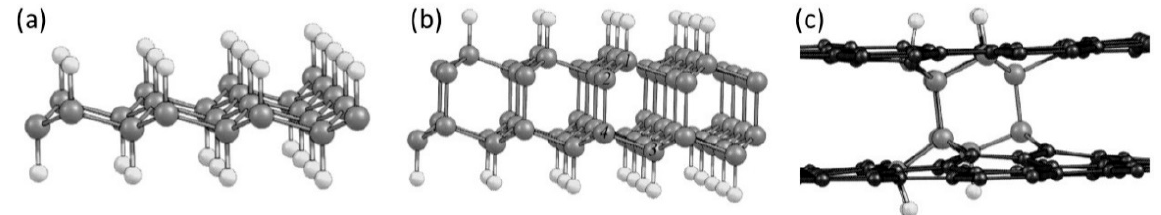
Figure 1. Atomic structures of ( a ) graphane and ( b ) diamane, and ( c ) the mechanism of the diamane nucleus formation on the initial graphene bilayer: hydrogen atoms are attached on two sides and initiate the “adhesion” of carbon atoms over each other in neighboring layers organized with AB (Bernal) stacking. The carbon and hydrogen atoms are shown in dark and bright gray, respectively. Black circles in ( c ) correspond to sp 2 carbon atoms.